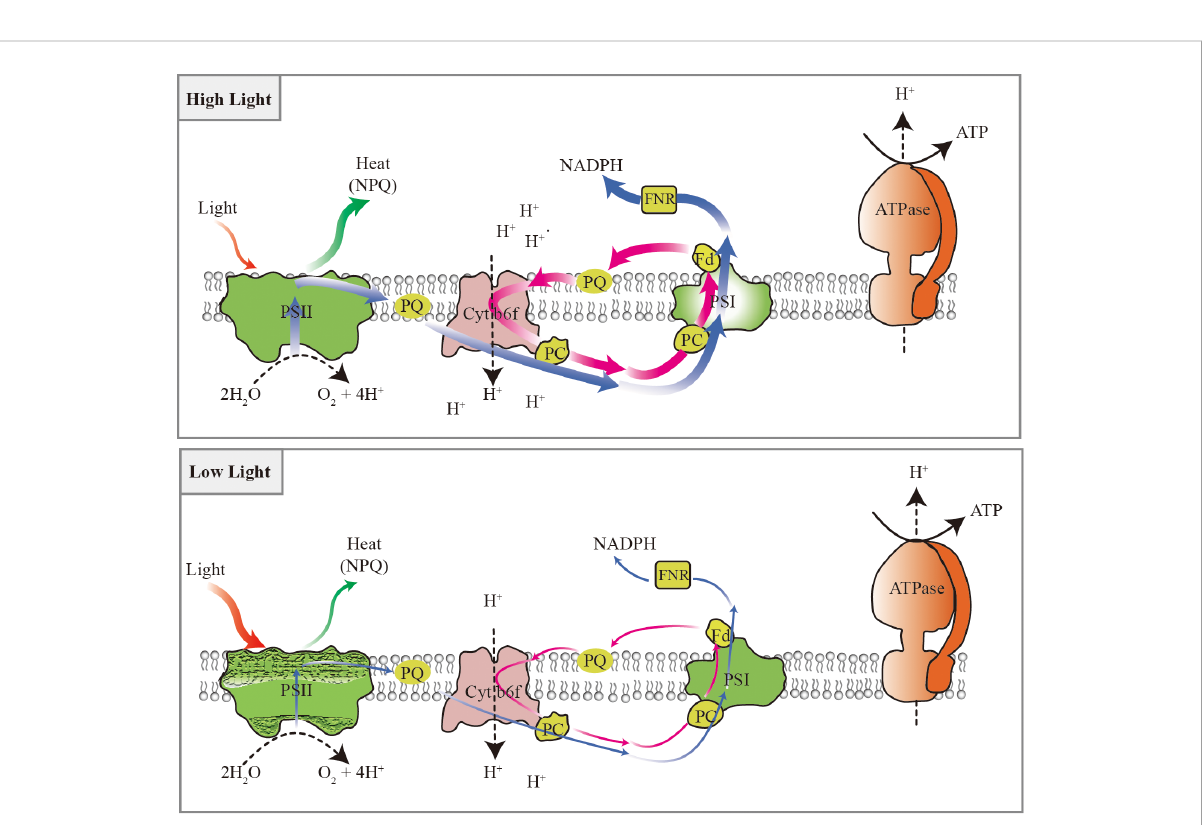
FIGURE 13 Photosynthetic adaptive strategies of the shade-tolerant species P. notoginseng grown under long-term light stress. Energy dissipation through NPQ predominates in response to high light, electron transport plays an important role in utilizing excess light energy, and the moderate photoinhibition of PSII and higher cyclic electron fl ow around PSI might avoid the damage of the PSI under high light. The absorbed light energy cannot be effectively dissipated and utilized through NPQ and electron transport under low light. Cyclic electron fl ow around PSI also cannot completely protect PSII from damage under low light. Blue arrows represent linear electron transport, magenta arrow represents cycle electron transport, red arrows represent absorbed light energy, green arrows represent the capability to dissipate heat, craquelure represent the damage of photosystem. The thickness of the lines represents the strength of electron transport, light energy absorption, and heat dissipation. The black dotted line indicates the transport pathway of H + . The black solid line indicates the synthetic path of